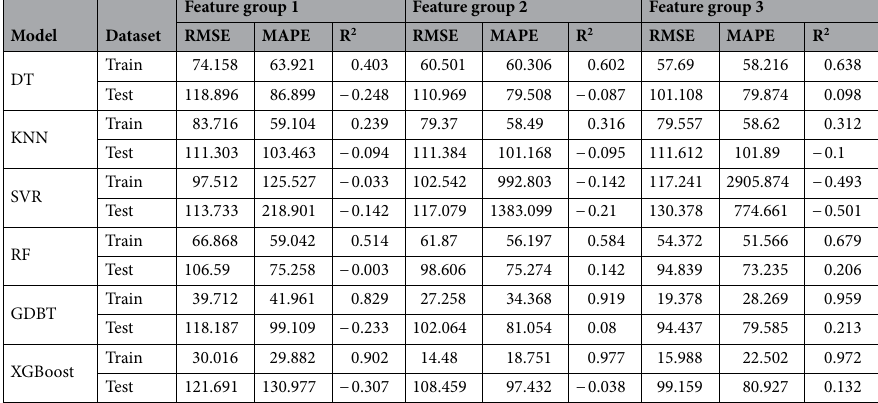
Table 2. Prediction results of different algorithms for each feature